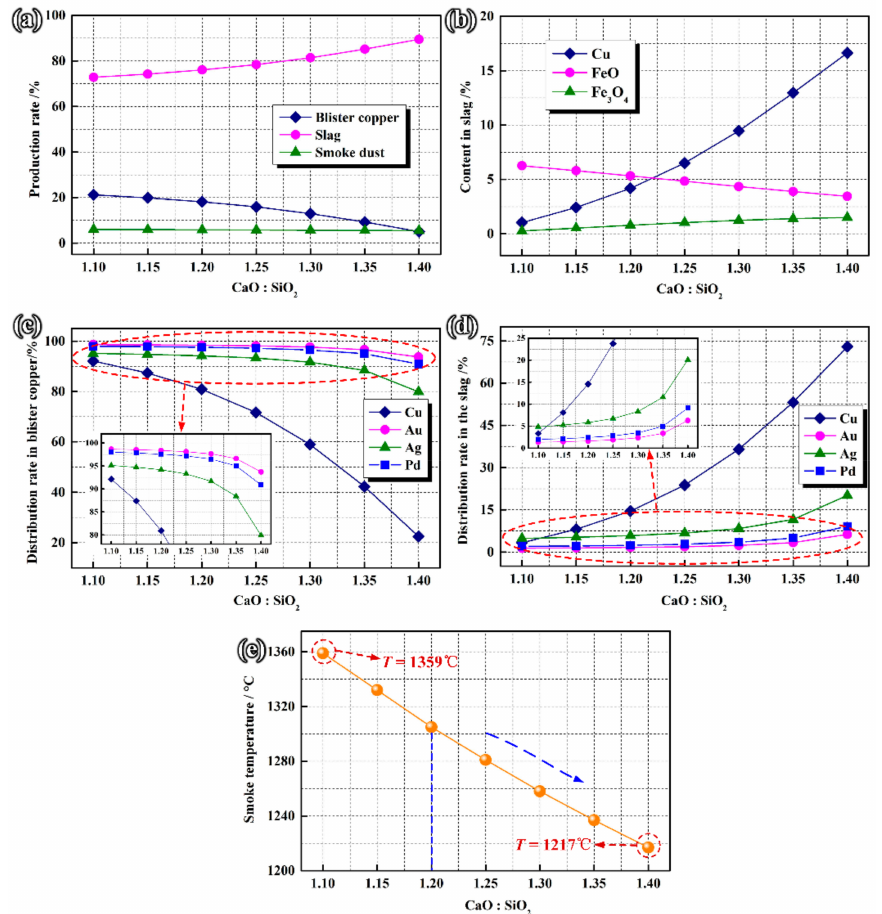
Figure 7. The influence of various CaO:SiO 2 ratios in the slag on the top-blowing smelting process of electronic waste. ( a ) Production rate of blister copper, slag and smoke dust; ( b ) content in slag; ( c ) distribution rate of various metals in blister copper; ( d ) distribution rate of different metals in the slag; ( e ) smoke